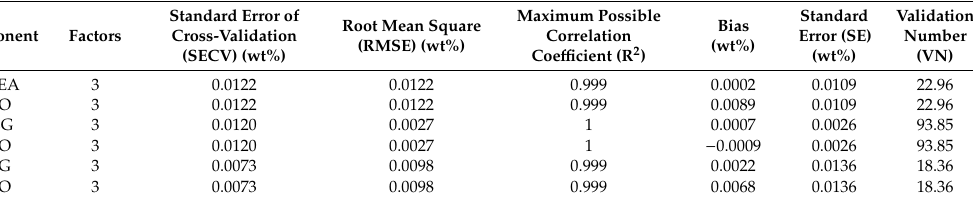
Table 3. Summary of results for two-component systems.